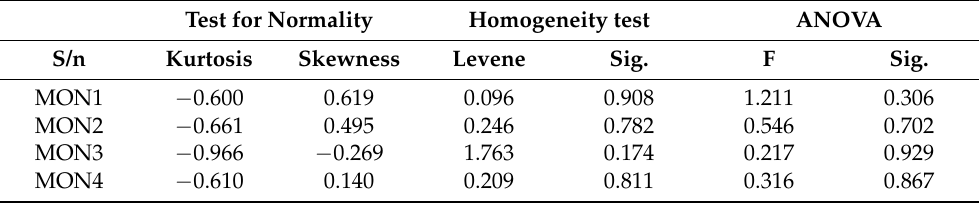
Table 15. One-way ANOVA on H&S considerations in contract administration and